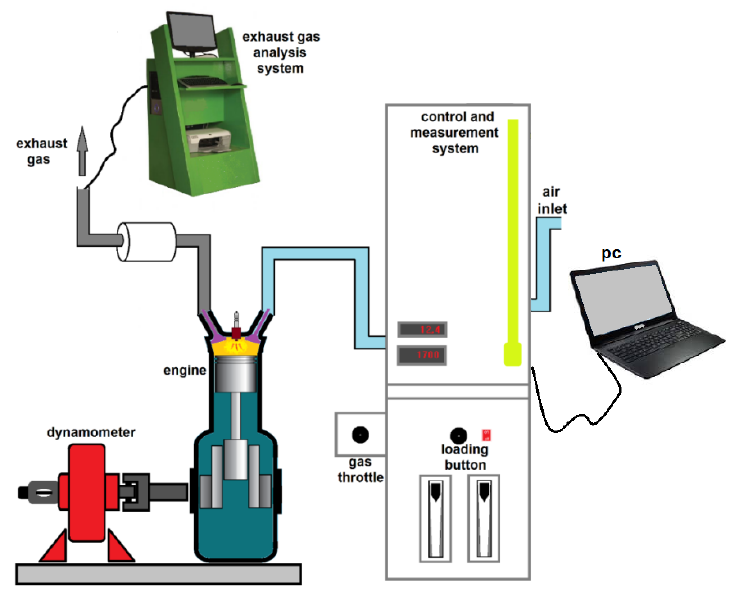
Fig. 2. Schematic view of the experimental